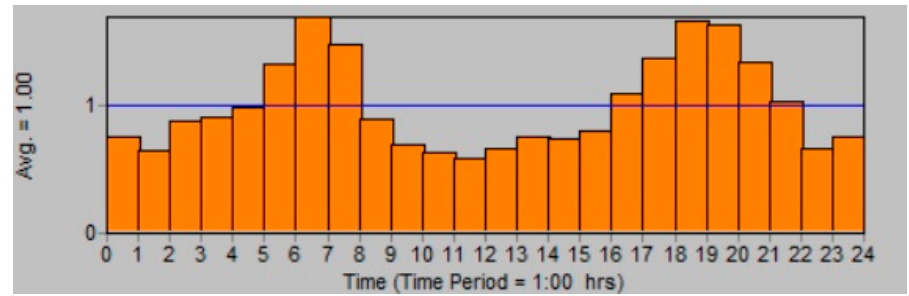
Figure 3. Daily water consumption pattern for a selected domestic